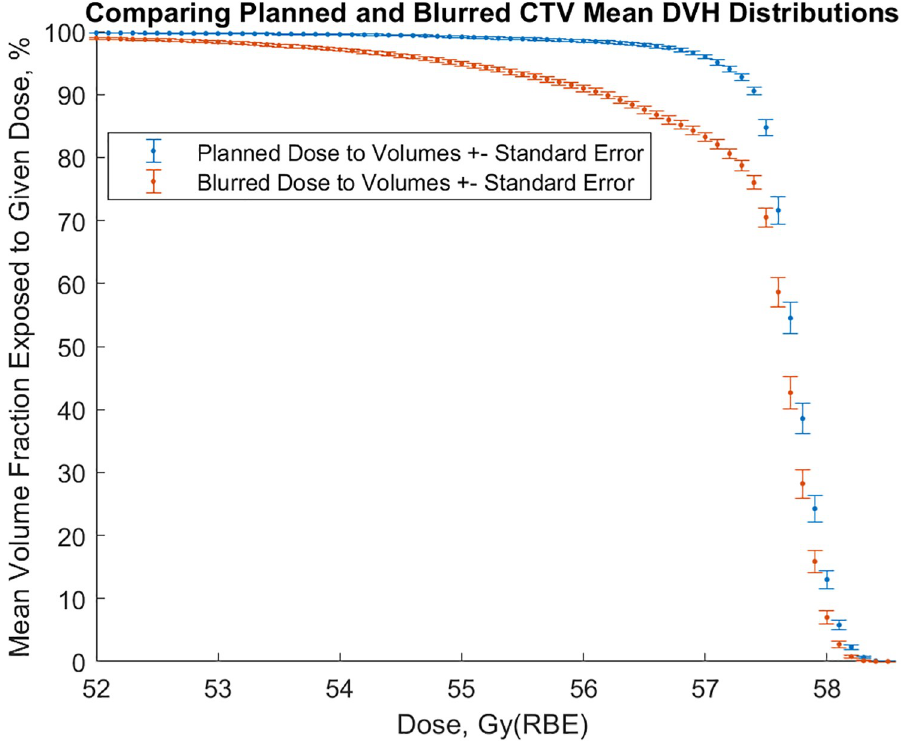
Fig 6. Comparison of mean planned and blurred CTV DVH from 40